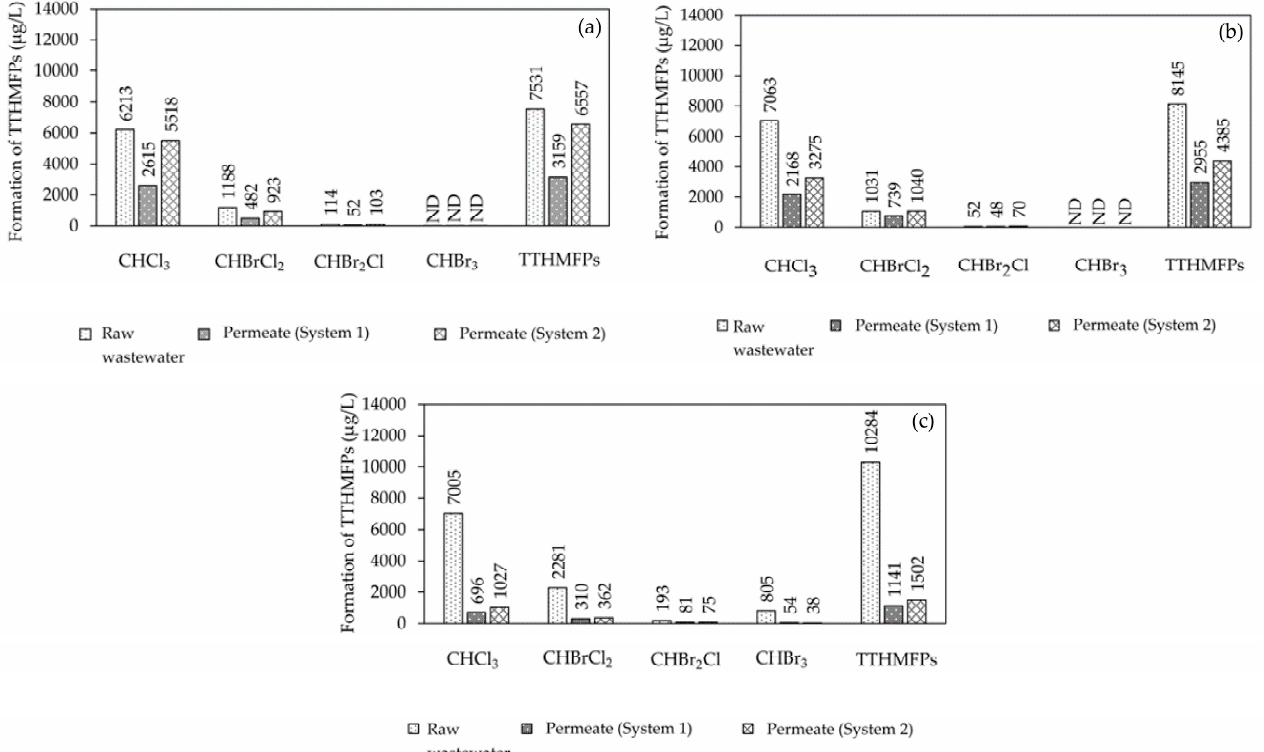
Table S2. alkalinities of raw wastewater and wastewater in the A/O-MBR and O-MBR systems; Table S3. dissolved oxygen in raw wastewater and wastewater in the A/O-MBR and O-MBR systems; Table S4. MLVSS/MLSS of raw wastewater and wastewater in the A/O-MBR and O-MBR systems; Table S5. efficiencies of A/O-MBR and O-MBR systems on total Kjeldahl nitrogen (TKN)